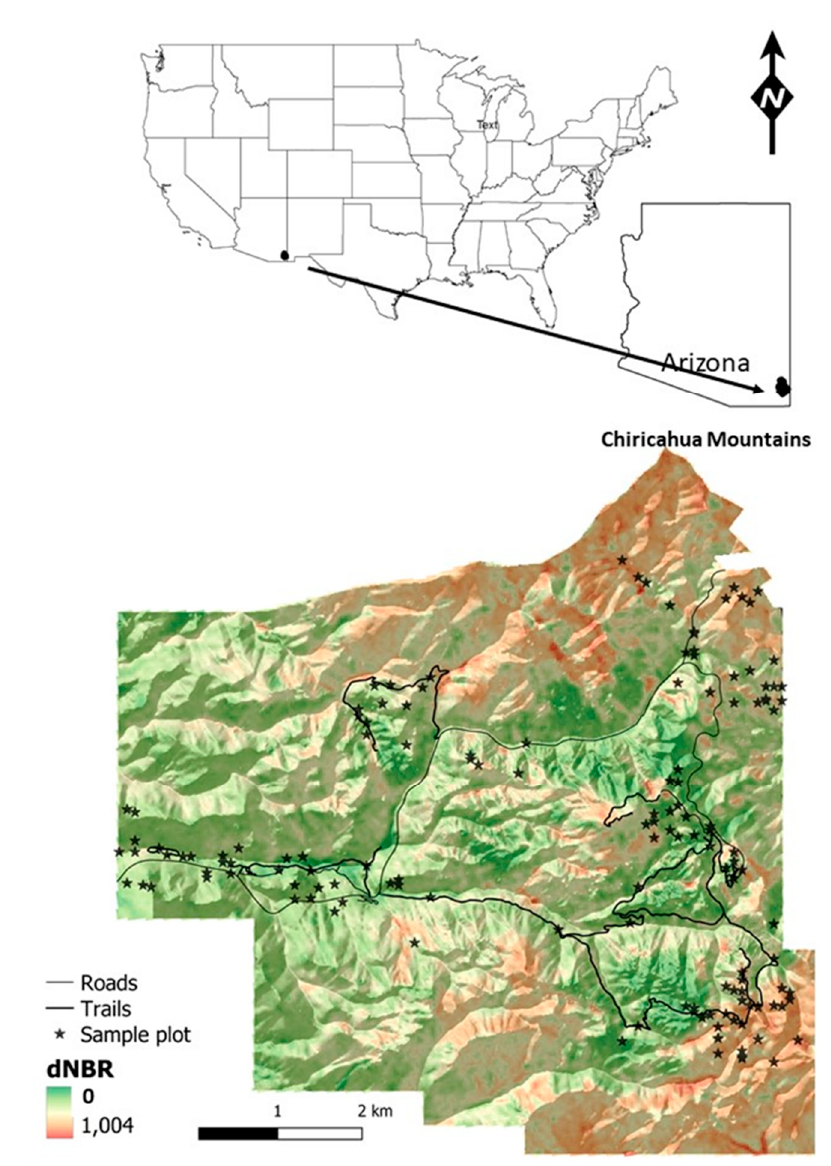
Figure 1. Map of the Chiricahua National Monument, Cochise County, Arizona. Vegetation transect locations are indicated with stars. Plots are overlain on Horseshoe Two Fire differenced normalized burn ratio (dNBR)-derived fire severity data [54] .